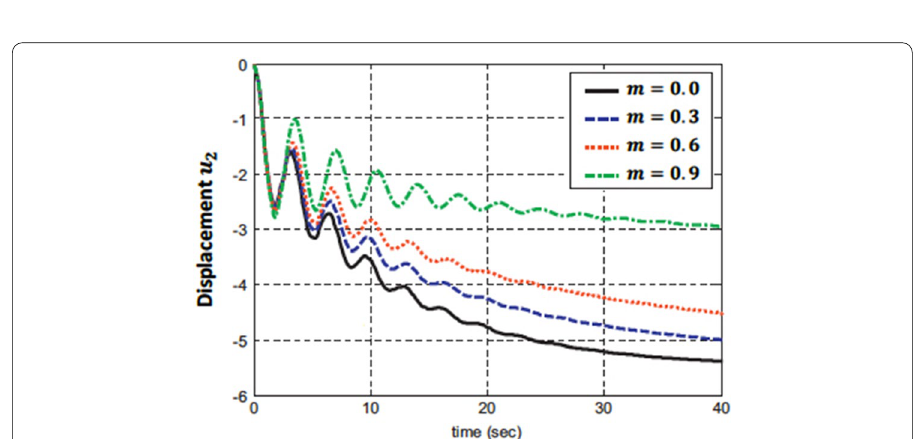
Fig. 5 Variation of the nonlinear displacement u 2 with time τ for different values of functionally graded parameter